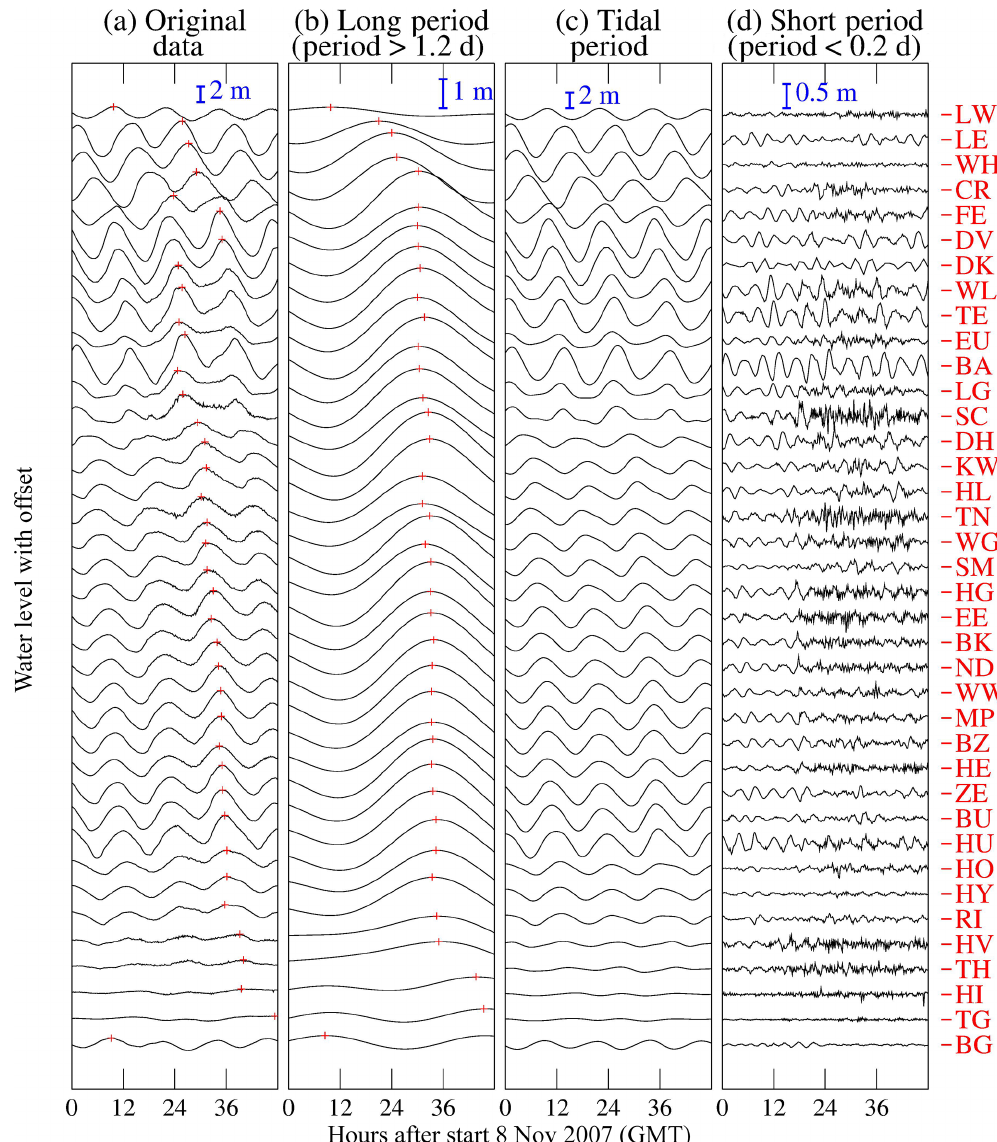
Figure 3. (a) Original tide gauge time series for the 2d interval of Storm Tilo 8–9 November 2007 and reconstructions for the (b) long period component (periods > 1 . 2d; storm surge), (c) intermediate period component (periods in the range 0.2–1.2d; tide), and (d) short period component (periods < 0 . 2d; harbour seiche). The plot shows a subset of time series data from 38 stations, and the full data set of 76 stations used in this project is shown in the